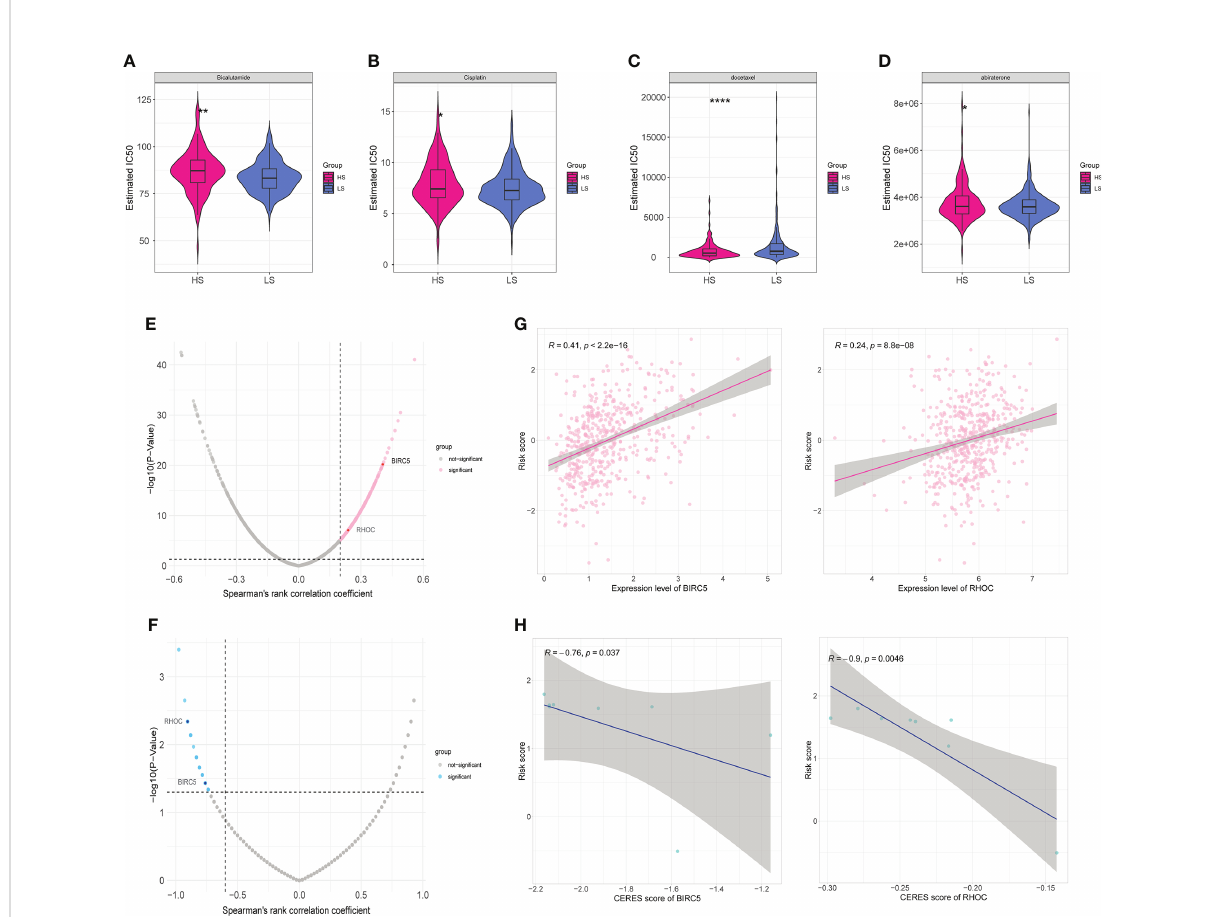
FIGURE 6 Drug sensitivity and identi fi cation of potential drug targets. (A – D) Estimated IC50 indicates the ef fi ciency of four common drugs in prostate cancer (Bicalutamide (A) , Cisplatin (B) , Docetaxel (C) , and Abiraterone (D) ) in HS and LS groups. (E) Volcano plot of Spearman ’ s correlations and signi fi cance between risk score and expression of drug targets. Red dots indicate the signi fi cant positive correlations (Spearman ’ s r>0.2, p<0.05). (F) Volcano plot of Spearman ’ s correlations and signi fi cance between risk score and CERES score of drug targets. Blue dots indicate the signi fi cant negative correlations (Spearman ’ s r < − 0.6, P <0.05). (G) Scatter plots of Spearman ’ s correlations and signi fi cance between risk score and expression of BIRC5 (left) and RHOC (right). (H) Scatter plots of Spearman ’ s correlations and signi fi cance between risk score and CERES score of BIRC5 (left) and RHOC (right). (*P < 0.05, **P < 0.01, ****P <